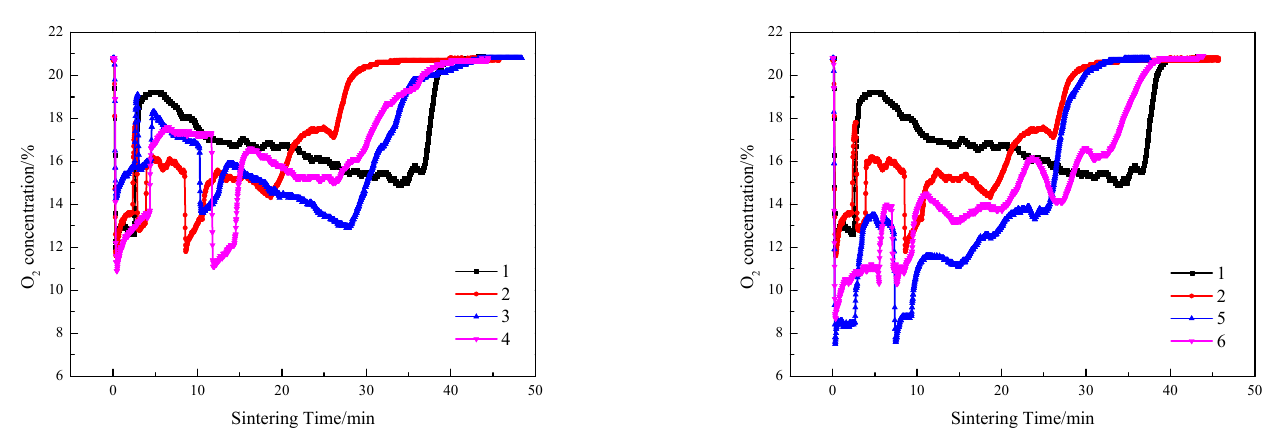
Figure 8. CO 2 emissions of sintering flue gas at different ignition time intervals and layer height proportions.